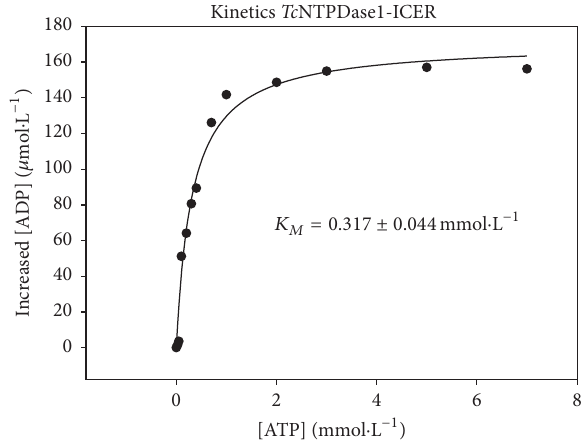
Figure 3: Representative chromatogram for the separation of ATP (3), ADP (2), and AMP (1) by a Phenomenex Luna C18 (100 ˚A 250 × 4.6 mm, 5 𝜇 m) analytical column at a flow rate of 1.0mL ⋅ min −1 , eluent Buffer C: MeOH (84 :16 v/v), and UV detection at 𝜆 = 254 nm. The chromatographic conditions of the two-dimensional method are described in Table 1.